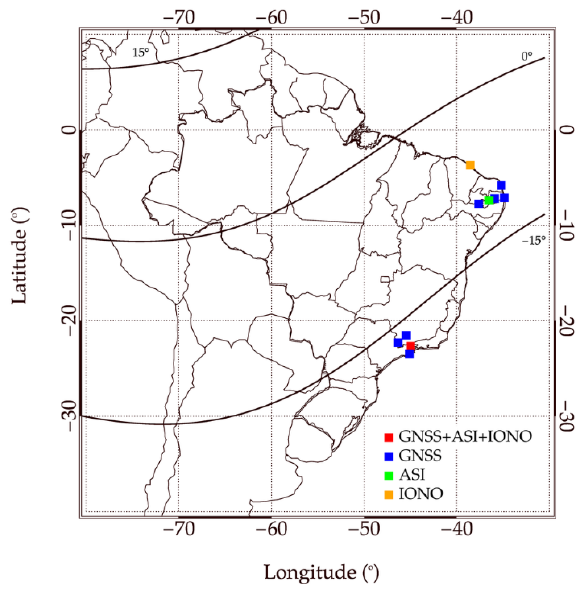
Figure 1. Map indicating the geographic locations of the instru- ments used in this study. The red symbol represents the site where GNSS receiver, All-Sky Imager (ASI), and ionosonde (IONO) are available. Blue symbols represent sites with only GNSS receivers, while green symbols indicate ASI sites, and orange symbols repre- sent IONO sites. The black lines identify the magnetic equator (0 ◦ ) and low latitudes (near ± 15 ◦ ) for the year